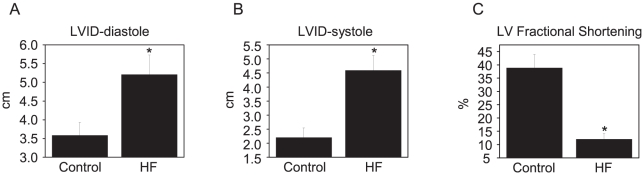
Heart failure animals have increased LV chamber size and reduced fractional shortening.A. LV internal diameter- end diastole is increased in the 4 month HF dogs. B. LV internal diameter- end systole is increased in the 4 month HF dogs. C. LV fractional shortening is reduced in the 4 month HF dogs. *p<0.05, n = 5–6.